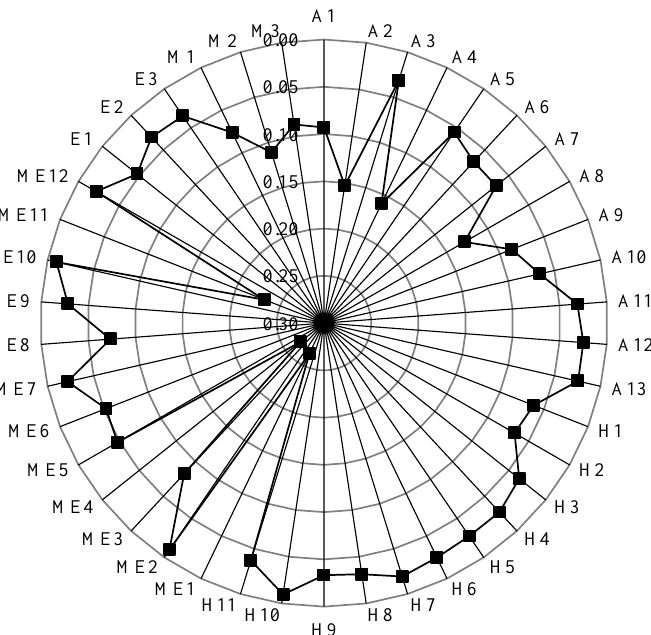
Figure 9. Vulnerability evaluation results.